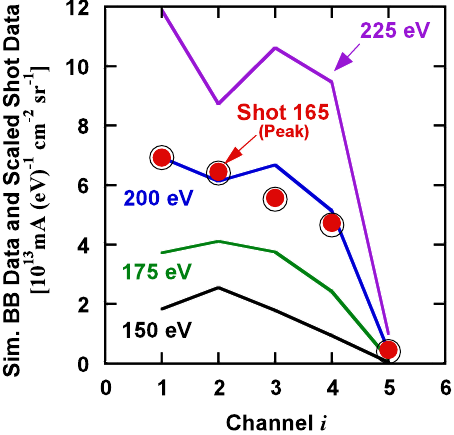
FIG. 4. Comparison of simulated Planckian data with scaled peak experimental data from Z -shot 165. The simulated profiles, ð T Þ vs i , were constructed from responses R ; . . . ; R d (Fig. 2) i 1 b 5 b ð E; 150 (cid:2) T (cid:2) 250 eV Þ . The experi- and Planckian spectra S bb vs i , were obtained in two ways: the solid mental profiles, D i ð t Þ in Fig. 3, while the points correspond to peak values of V i ð t Þ when V open circles derive from interpolated values of V i 1 -vs- i profiles have been independently scaled peaks. The two D i ð 200 eV Þ vs i to coincide with channel 1 of d i